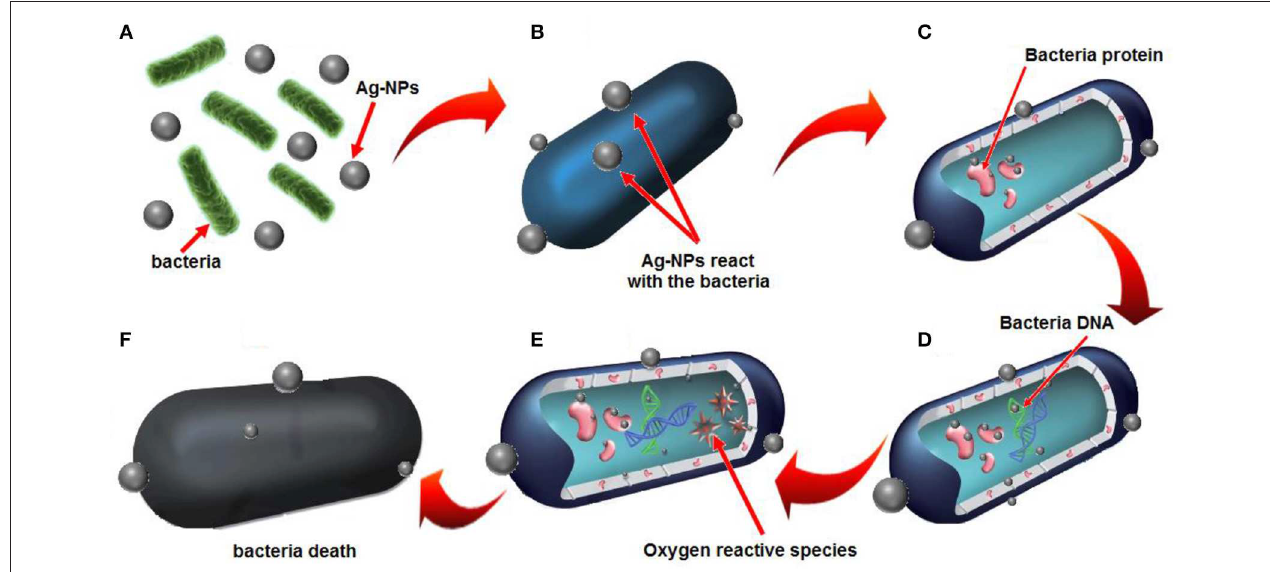
FIGURE 10 | Plausible mechanisms of antibacterial activity by E. spiralis /Ag-NPs is based on (A) electrostatic attraction of bacteria with E. spiralis /Ag-NPs, (B) the release of Ag + ions, (C) electrostatic attraction between Ag + ions and bacteria protein, (D) the interference with bacterial DNA replication, (E) resulting in oxygen reactive species, (F) bacteria